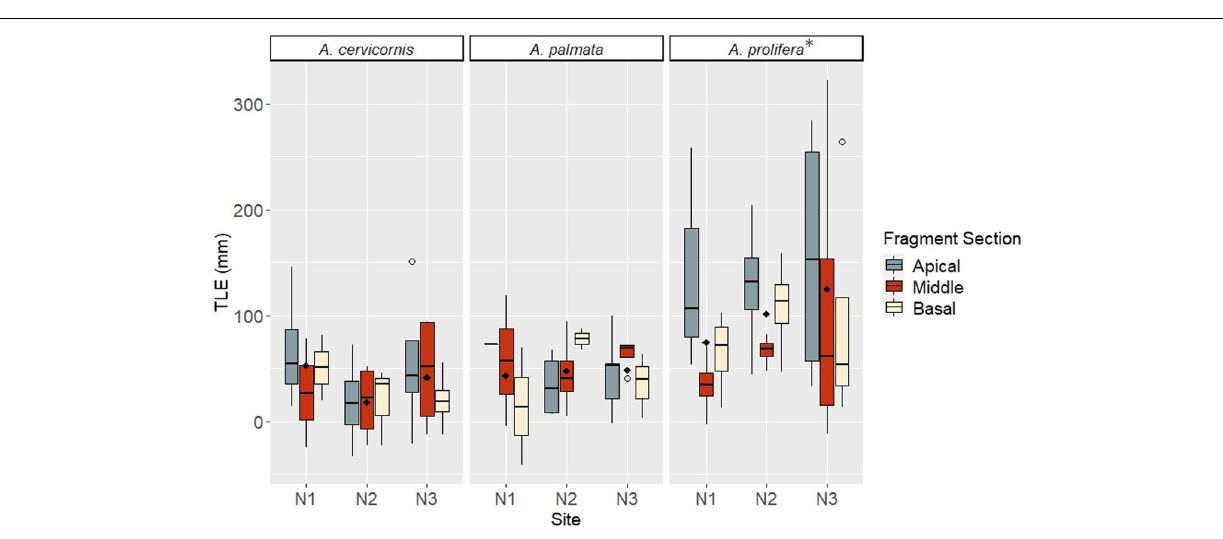
FIGURE 5 | Growth (TLE) by taxa, fragment section, and site at 12 months. Taxa are listed along the top bar of each plot. Site is listed along the x-axis within each taxa group. Fragment sections are differentiated by color in the legend on the right. Open circles indicate outliers; filled diamonds indicate mean values for the site. A * indicates